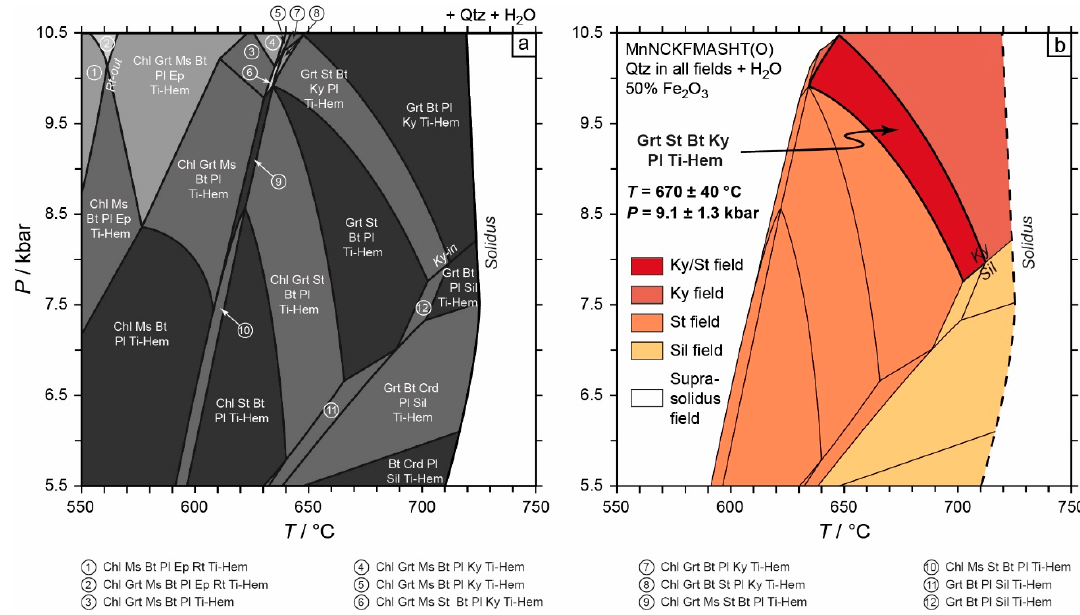
Figure 15. PT pseudo-section calculated for sample CS16_292b. ( a ) Pseudo-section showing labelled metamorphic assemblage fields. Assemblage fields are shaded according to the number of degrees of freedom, with higher-variance assemblages represented by darker shading. Ky-in and Rt-out lines are shown. ( b ) Highlight of the stability fields of kyanite, staurolite and sillimanite index minerals. The interpreted peak metamorphic assemblage field is shaded in red and labelled with bold text. Ky-Sil univariant line is shown. The right white domain corresponds to the supra-solidus field. Dashed line represents the solidus. Mineral abbreviation: biotite (Bt), chlorite (Chl), cordierite (Crd), epidote (Ep), garnet (Grt), kyanite (Ky), muscovite (Ms), plagioclase (Pl), quartz (Qtz), rutile (Rt), sillimanite (Sil), staurolite (St) and Ti-hematite